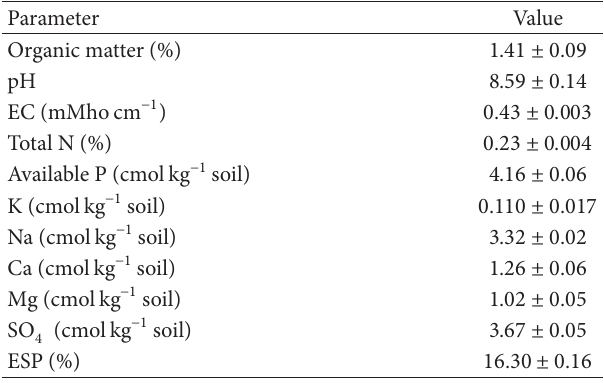
Table 2: Basic chemical properties of the initial alkaline soil.